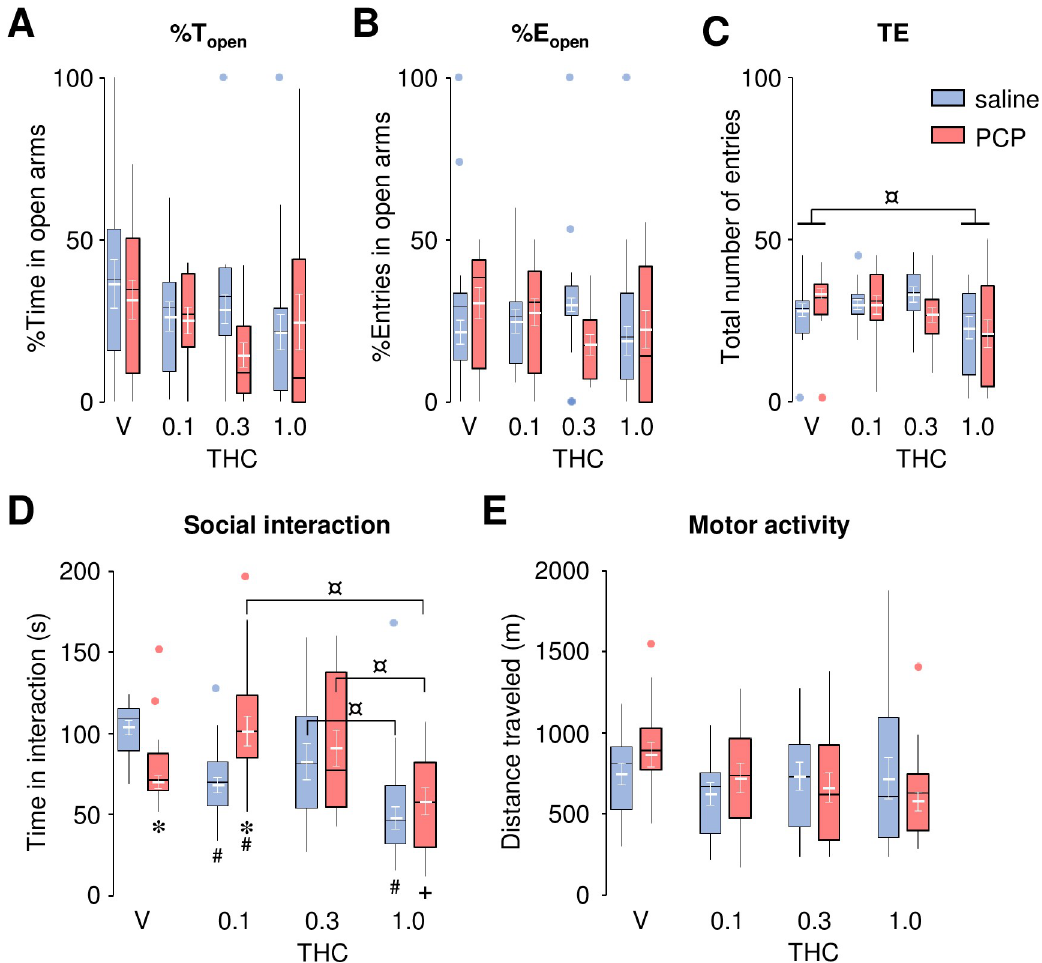
Fig 1. Effects of THC (0.1–1.0 mg/kg) on anxiety-like behavior, social interaction and motor activity in saline- and PCP- treated rats. Percent time spent in the open arms (%T open ; A ), percent of open arms entries (%E open ; B ) and total number of entries (TE; C ) in the EPM task. Time spent in social interaction ( D ). Distance traveled in the Actimot activity box following d - amphetamine (0.5 mg/kg, i.p.) administration ( E ). The raw data for this figure are reported in the supplemental file (S1 Raw data) and are summarized here as boxplots computed using Carling’s modification [42]; outliers are depicted as blue (saline) or red (PCP) circles. Values (in white) are expressed as mean ± S.E.M. (n = 10–14 per group). � P < 0.05 compared to saline-treated controls, # P < 0.05 compared to vehicle (V) controls, + P < 0.05 compared to saline-treated vehicle (V) controls, ¤ P < 0.05 (Newman-Keuls post-hoc